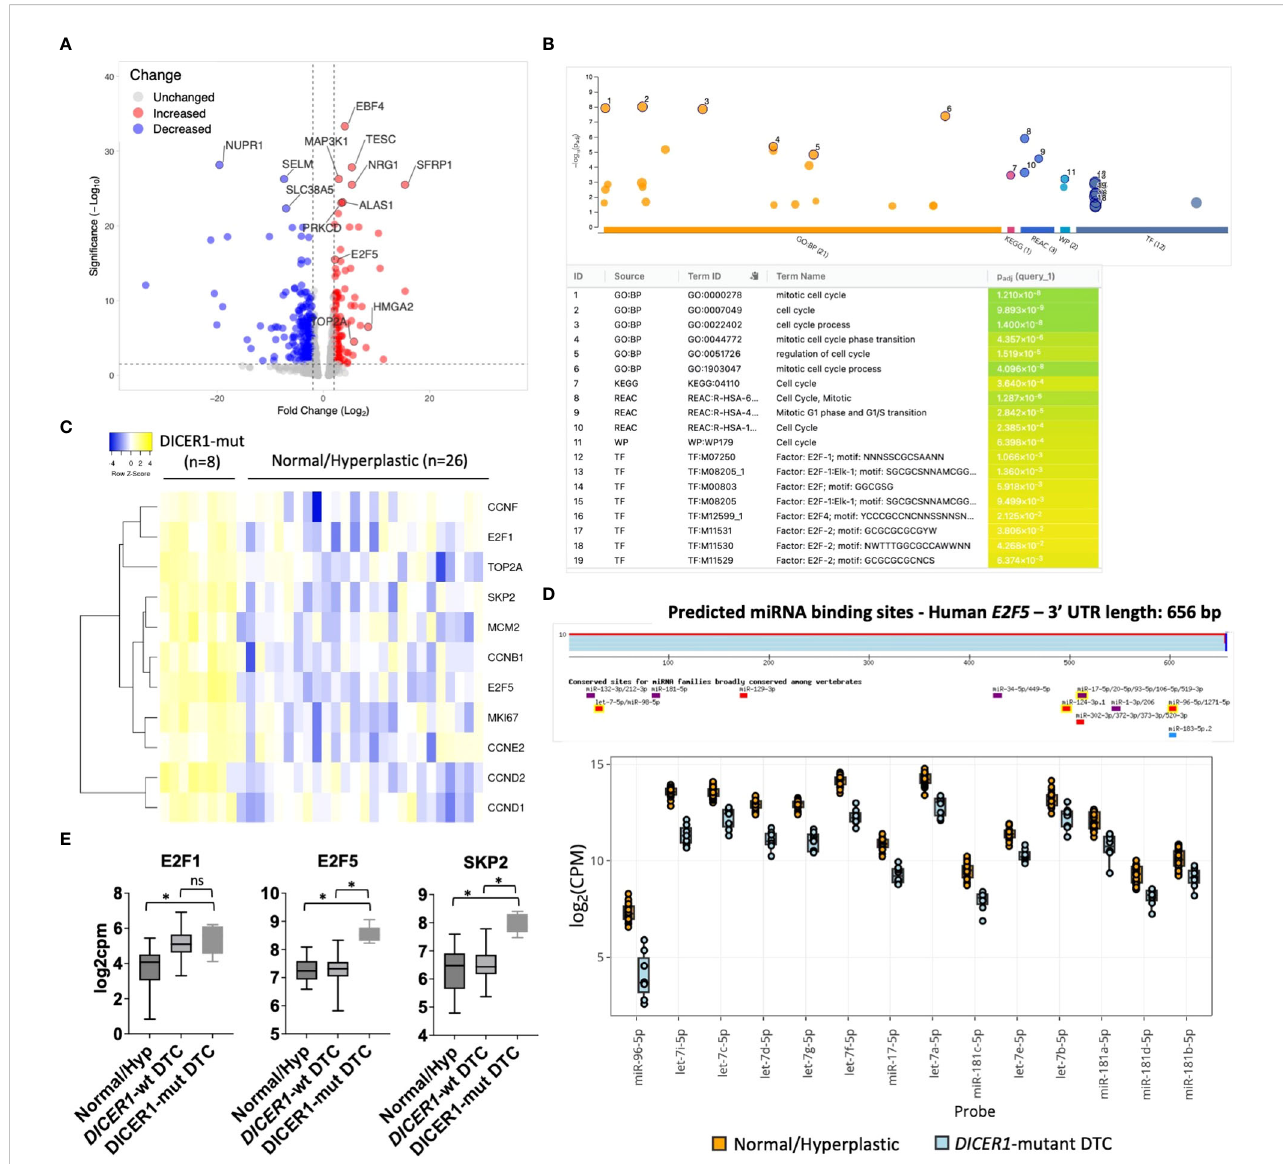
FIGURE 4 DICER1 RNase IIIb mutations positively regulate mitotic cell-cycle genes. (A) .Volcano plot highlighting differentially expressed mRNAs between DICER1 - mut differentiated thyroid cancer (DTC) (n=8) vs. non-neoplastic/benign hyperplastic group (n=26). The blue dots denote downregulated gene expression and the red dots denote upregulated gene expression. Grey dots denote gene expression without signi fi cant differences (FC>2 and FDR ≤ .05). (B) Functional enrichment analysis using g:Pro fi ler version e106_eg53_p16_65fcd97. Analysis of 247 upregulated genes reveals enrichment for genes related to mitotic cell-cycle in different databases (GO, KEGG, Reactome, Wikipathways) and over-representation of E2F transcription factor binding sites according to TRANSFAC database. (C) Heatmap displaying increased expression of E2F1 and E2F5 transcription factors and selected genes related to cell-cycle in DICER1 -mutant tumors vs. non-neoplastic/benign hyperplastic tissues. Yellow: upregulated genes; Blue: downregulated genes. (D) Predicted miRNA binding sites in the 3 ’ untranslated region (UTR) of E2F5 using TargetscanHuman 8.0 (Top) and downregulation of miRNAs predicted to target E2F5 3 ’ UTR in DICER1 -mut vs non-neoplastic/hyperplastic tissues (bottom). (E) Increased expression of E2F1 , E2F5 and SKP2 mRNA in DICER1 -mut DTC vs. DICER1 -wt DTC and non-neoplastic/hyperplastic tissues. Asterisk represent p < 0.05; ns: not signi fi